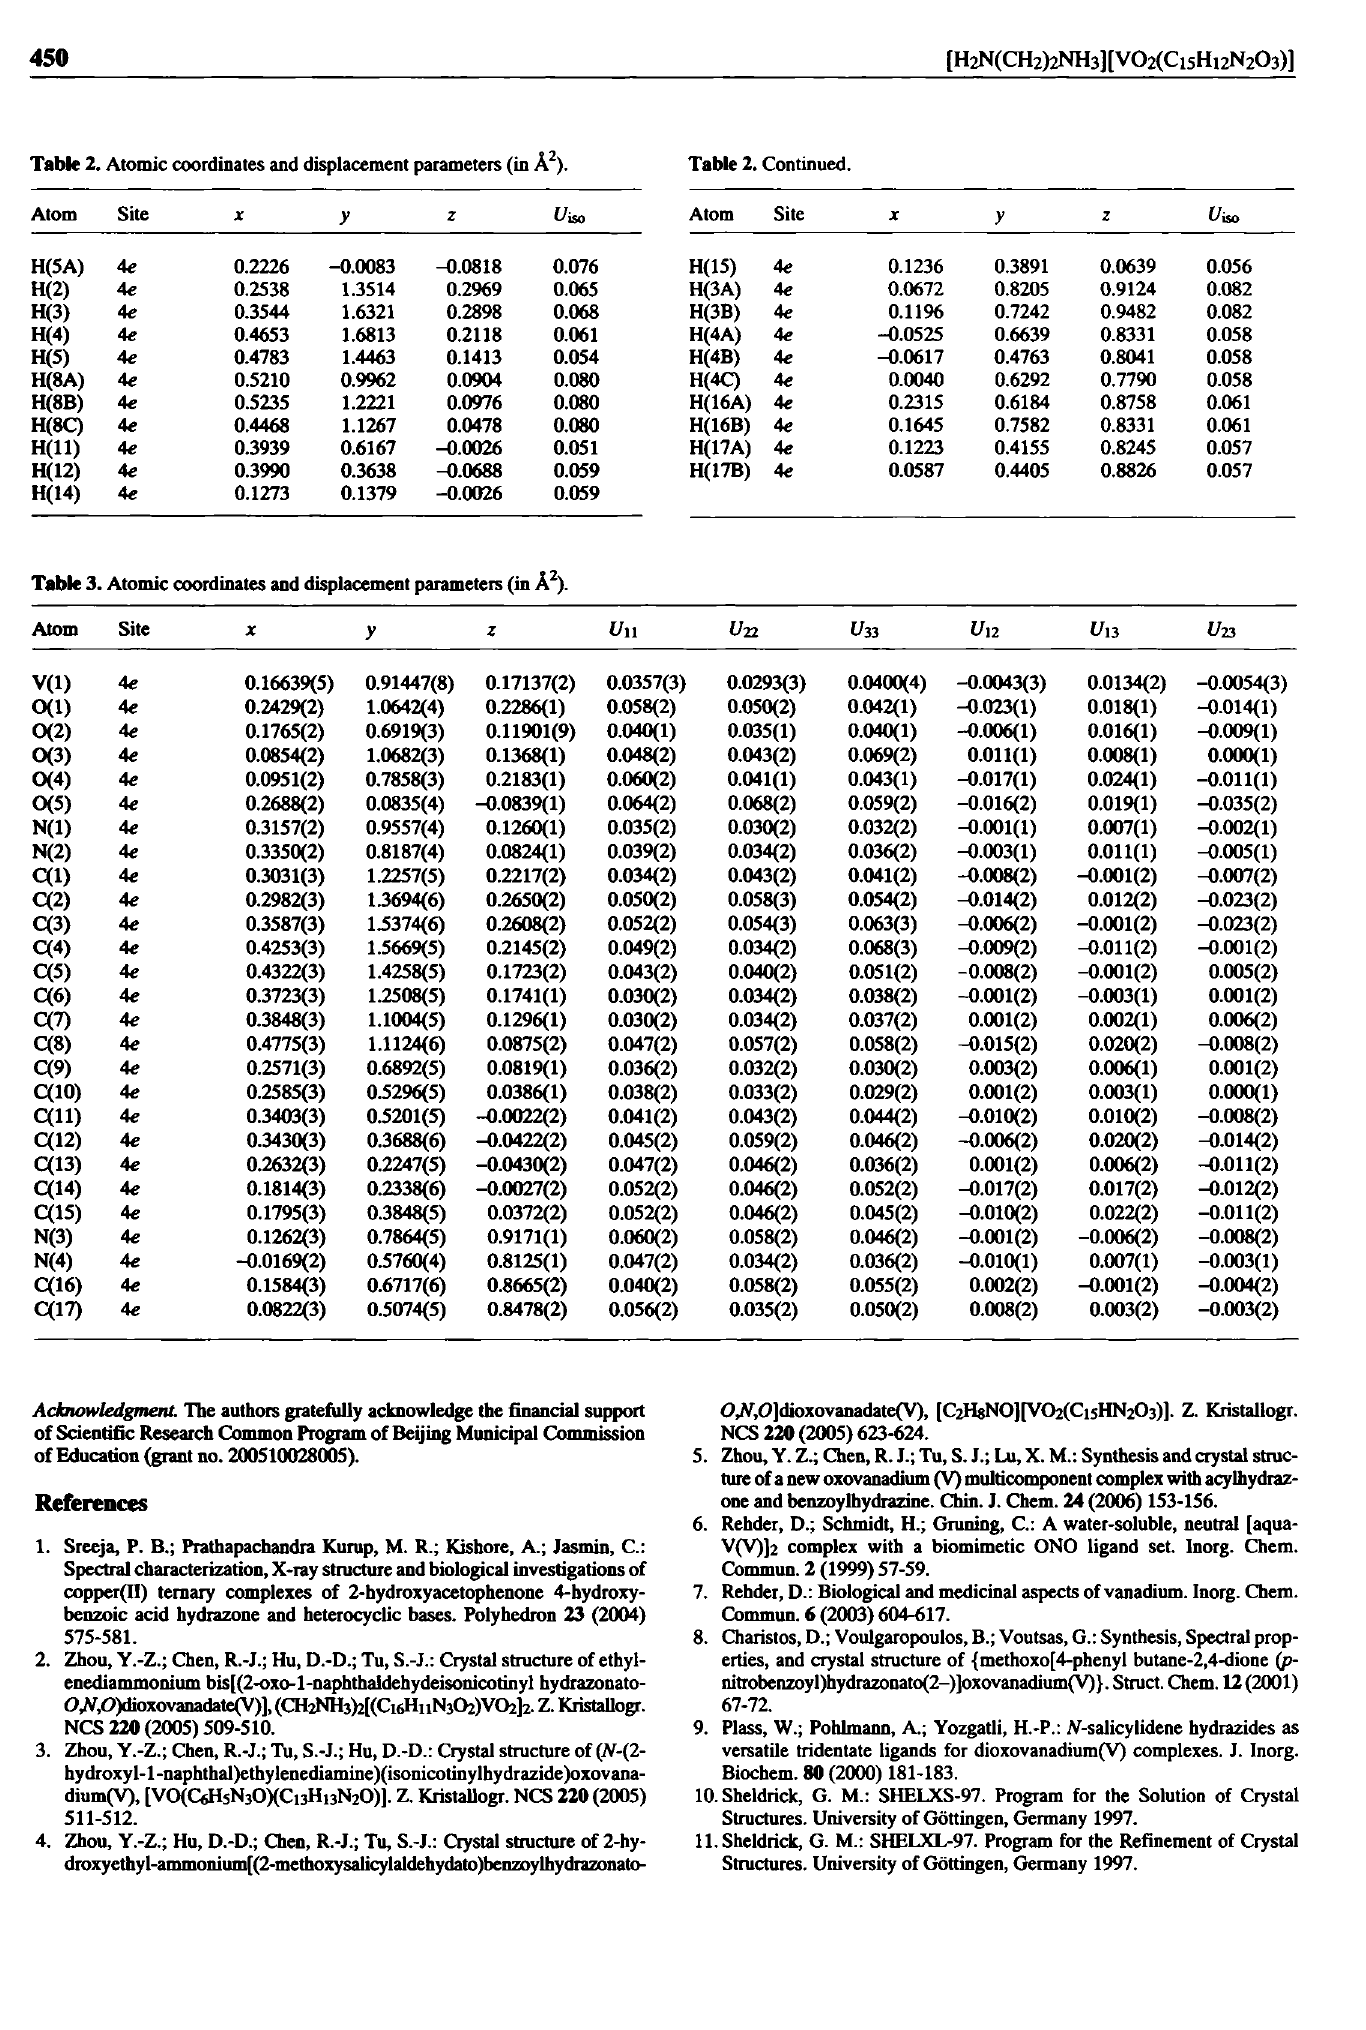
Table 2. Atomic coordinates and displacement parameters (in A 2 ).